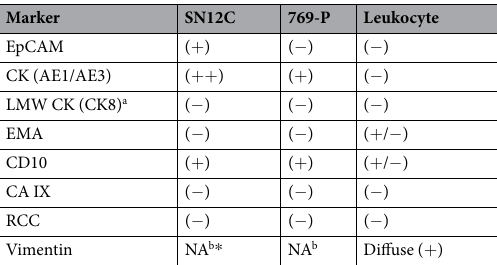
Marker SN12C 769-P